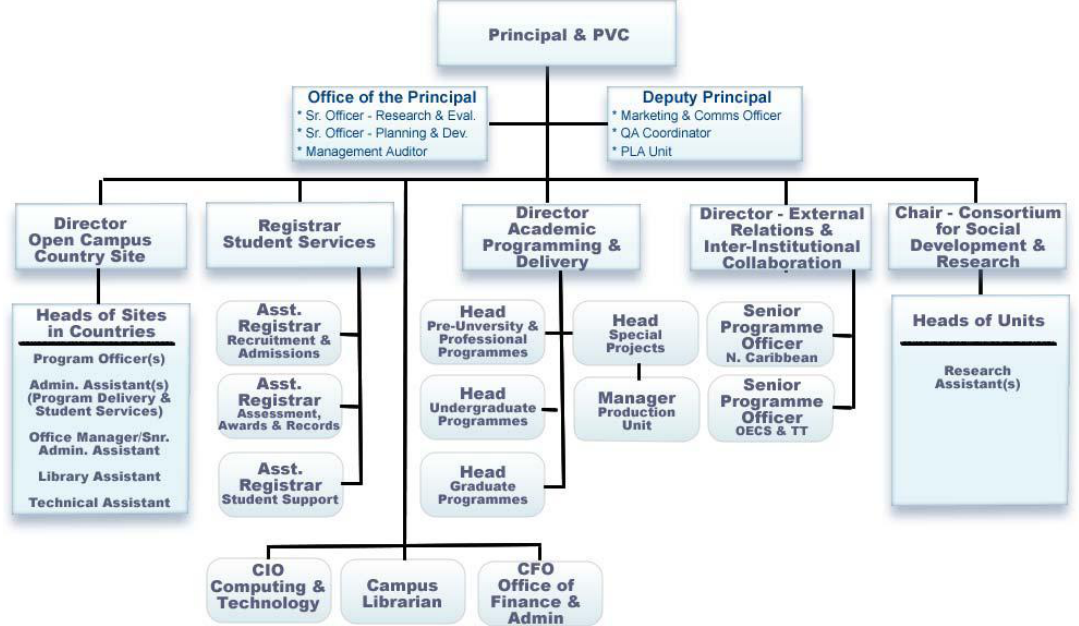
Figure 2. Open Campus Organizational Chart. Source: Adapted from The University of the West Indies Open Campus Progress Report,